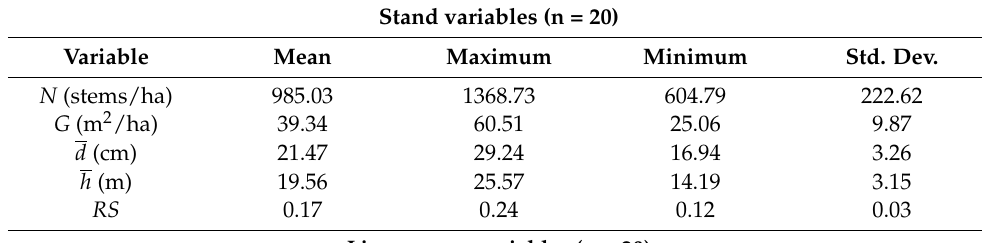
Table 1. Statistics for the main tree and stand variables. Stand variables (n = 20) Variable Mean Maximum Minimum Std.